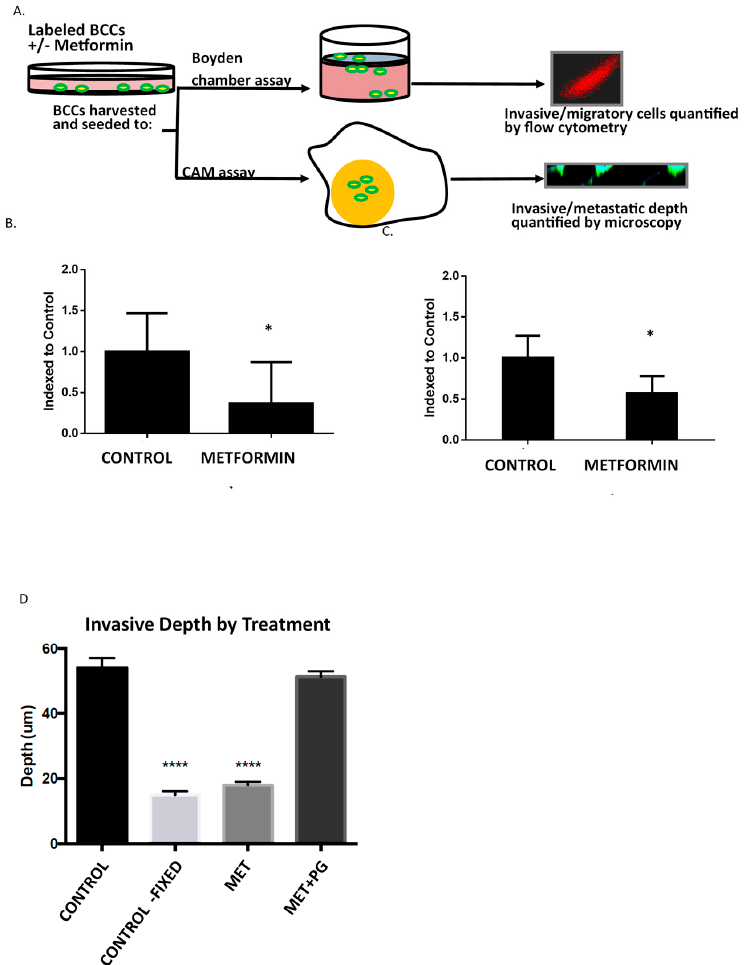
Figure 4. Metformin attenuates breast cancer cell migration, invasion, and metastasis. ( A ) MDA-MB-231 cells were pre-exposed to metformin for 48 h, collected, and stained with CellTracker Green fluorescent stain. Stained cells were ceded in the upper chamber of a Boyden chamber plate in the absence ( B ), or the presence ( C ) of Matrigel coating. The number of transmigratory/invading cells in response to chemoattractant (DMEM with 10% FBS) were enumerated by flow cytometry and normalized to control. ( D ) Anti-metastatic action of metformin is reversed by PGE2. MDA-MB-231 cells were labeled with CellTracker Green (10 µ M) and seeded onto mesh squares placed on the chorioallantoic membrane (CAM) of 10-day old chicken embryos grown ex ovo. After 3 days, portions of the CAM-containing human cells were removed, fixed, stained with DAPI and visualized by fluorescence microscopy using an inverted laser confocal microscope with Z -axis control. Images were taken every 1 µ m for approximately 100 µ m, and the invasion maximum was defined by the leading edge of fluorescent cell invasion.